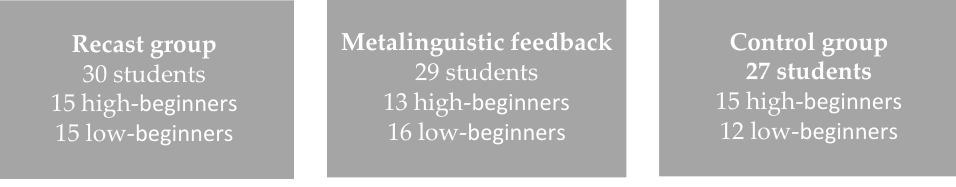
Figure 1. Participants and grouping.